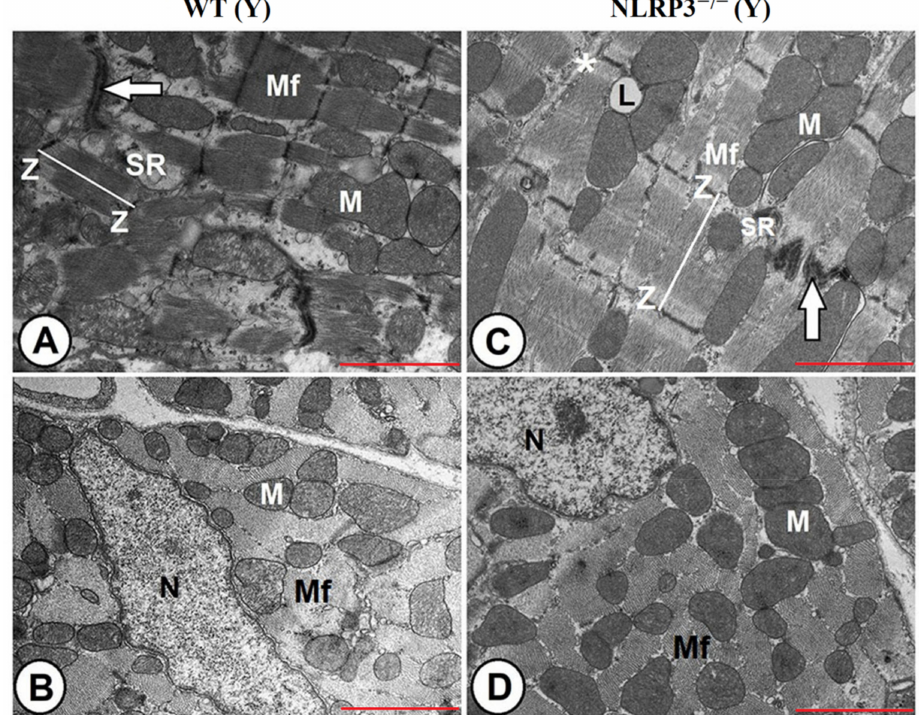
Figure 4. Ultrastructural architecture of cardiac muscle fibers in young WT and NLRP3 − / − mice. ( A , B ) Transmission electron micrographs of the LV of the Y WT mice clarifying well-organized longitudinally arranged myofibrils (Mf), with cross and longitudinal striations, centrally located nucleus (N), and intermyofibrillar sarcoplasmic reticulum (SR). Sarcomeres (line) are well aligned between each two successive Z-lines (Z), and cardiomyocytes branched repeatedly and attached strongly at the intercalated disc (arrow). The mitochondria were intact and compacted with clearly organized cristae, (M). ( C , D ) Transmission electron micrographs of the LV of the Y NLRP − / − mice showing cardiac myofibrils (Mf) of better structure with organized sarcomere between Z-lines (Z), highly compacted mitochondria (M), narrow interstitial spaces (asterisk), intermyofibrillar distribution of sarcoplasmic reticulum (SR), and lipid droplets (L). Nucleus (N) was centrally located. Bar “red line” = 2 µ